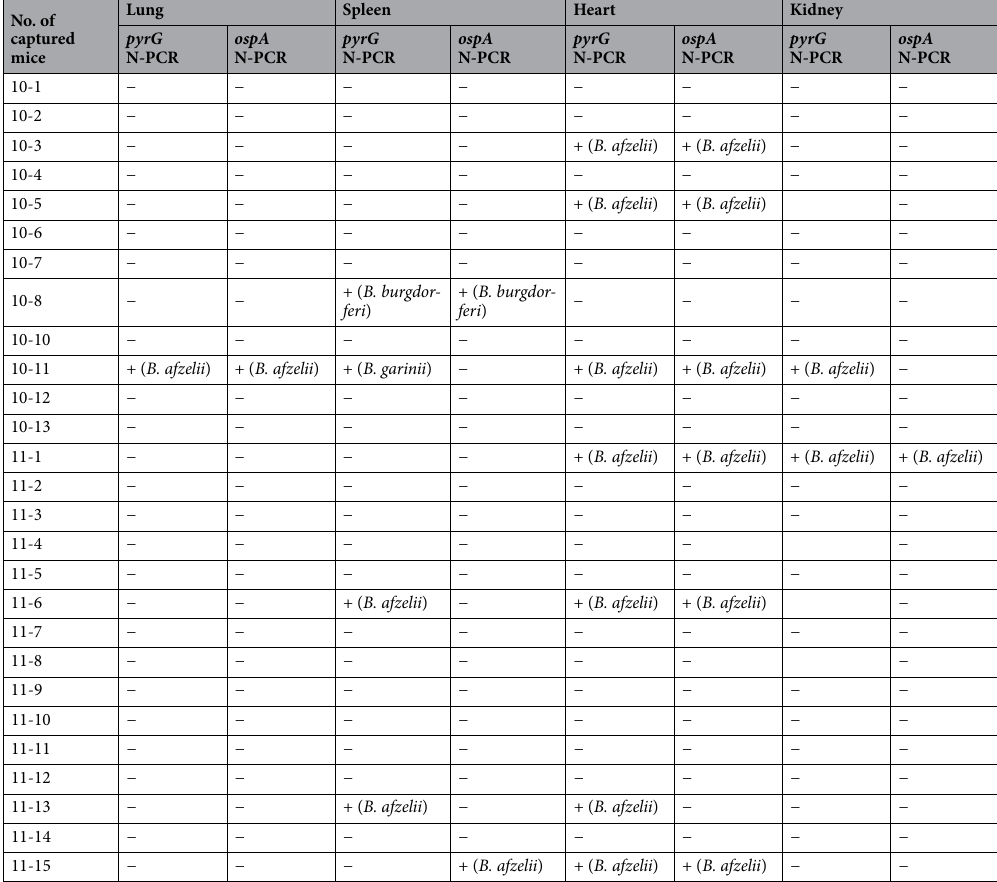
Table 1. PCR detection of Borrelia species in the organs of wild mice † . † pyrG , CTP synthase gene; ospA , outer surface protein A gene; N-PCR, nested PCR; −, negative; +,